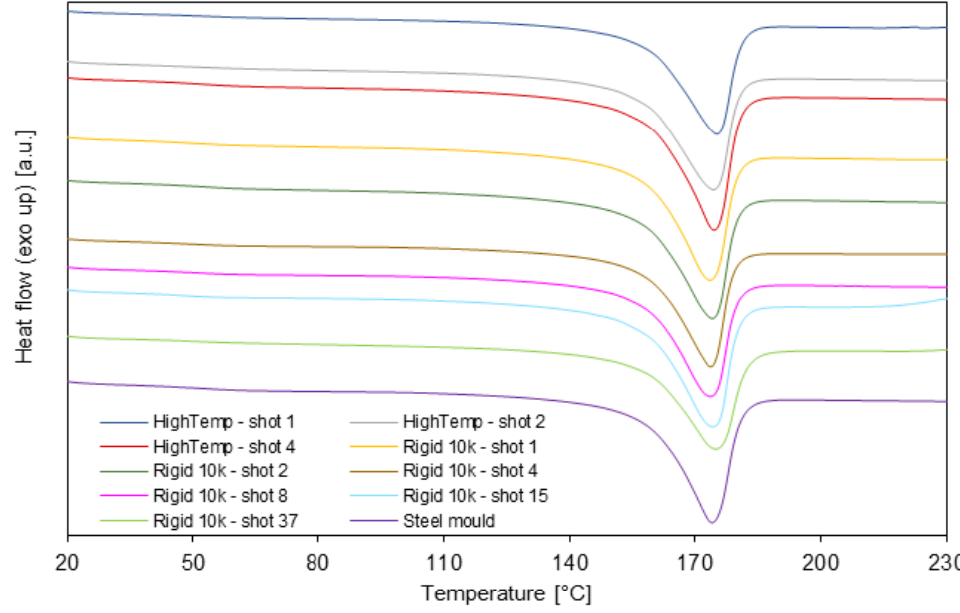
Figure 7. DSC thermograms obtained during the heating step for PP moulded in different moulds and at different shots.